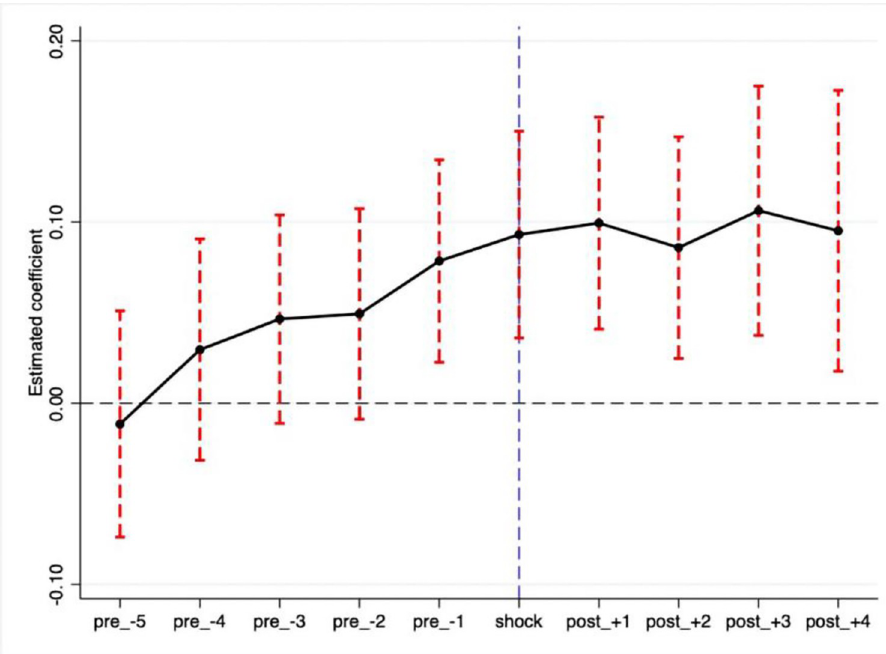
Fig 3. Parallel trend test. Notes: It is also noteworthy to mention that the “anticipation effect” (the estimated coefficient of the policy dummy variable pre_-1 was statistically significant in Fig 3) in this paper was also identified, which was consistent with [88]. In other words, firms may vigorously formulate strategic plans to respond to policy shock in advance.